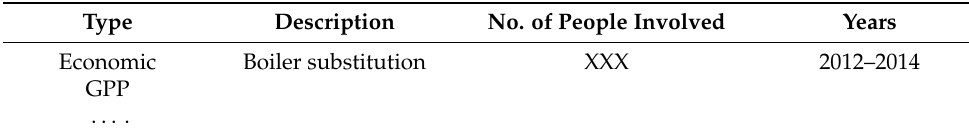
Table A5. Data requested for incentives and other